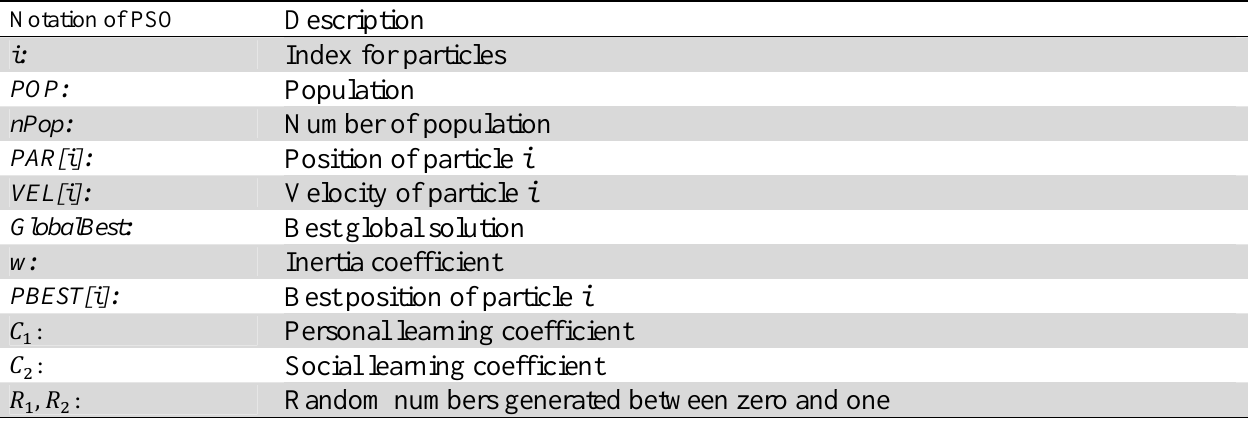
The parameters used for PSO method